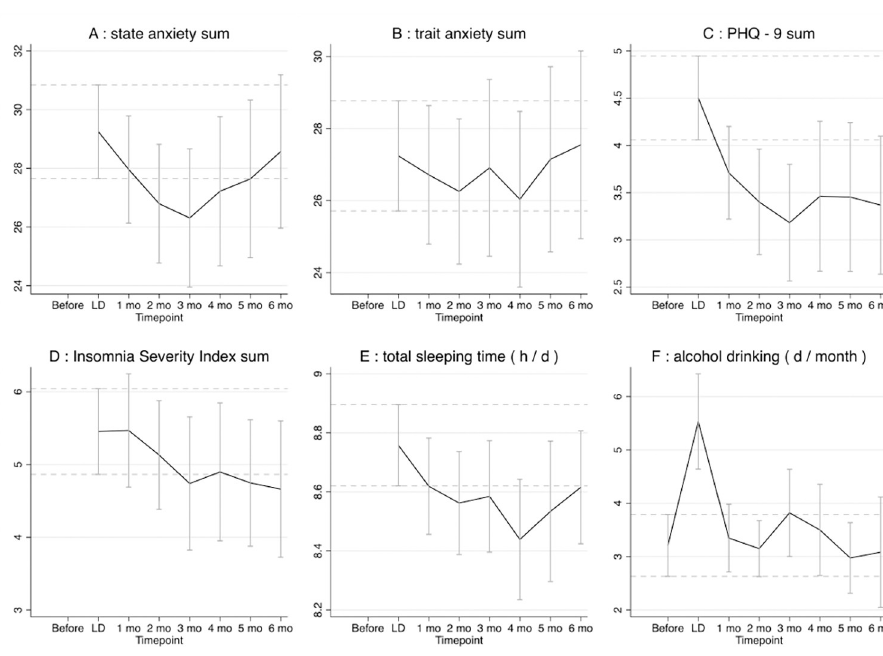
Fig 3. Symptoms of anxiety, depression, sleep disturbances and alcohol consumption. (A) state anxiety sum; (B) trait anxiety sum; (C) Patient Health Questionnaire-9 (PHQ-9) sum; (D) Insomnia Severity Index (ISI) sum; (E) total sleeping time (h/d); (F) alcohol drinking (d/month). The dotted lines represent the 95% confidence intervals of the first measurement of the variable, either during lockdown or from memory before